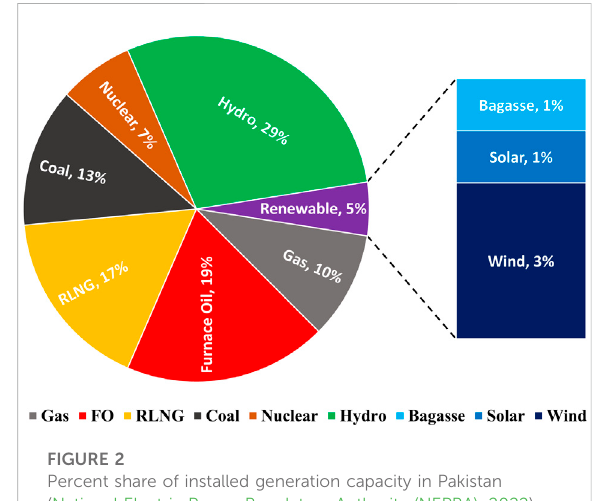
Percent share of installed generation capacity in Pakistan (National Electric Power Regulatory Authority (NEPRA),